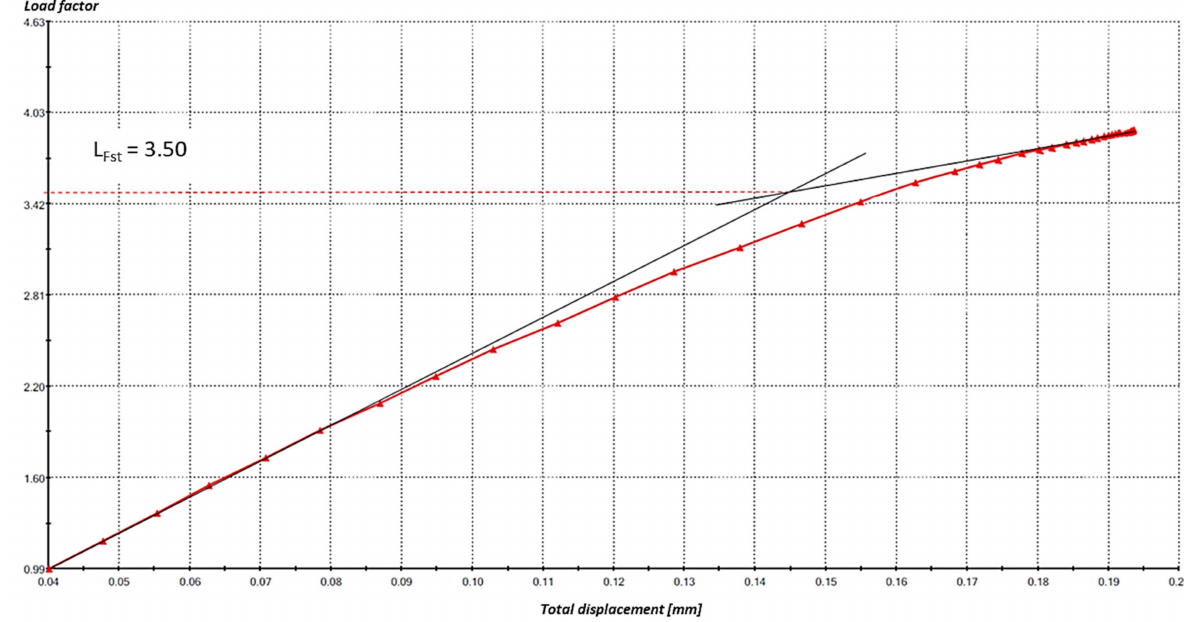
Figure 17. Load characteristics of the node 53